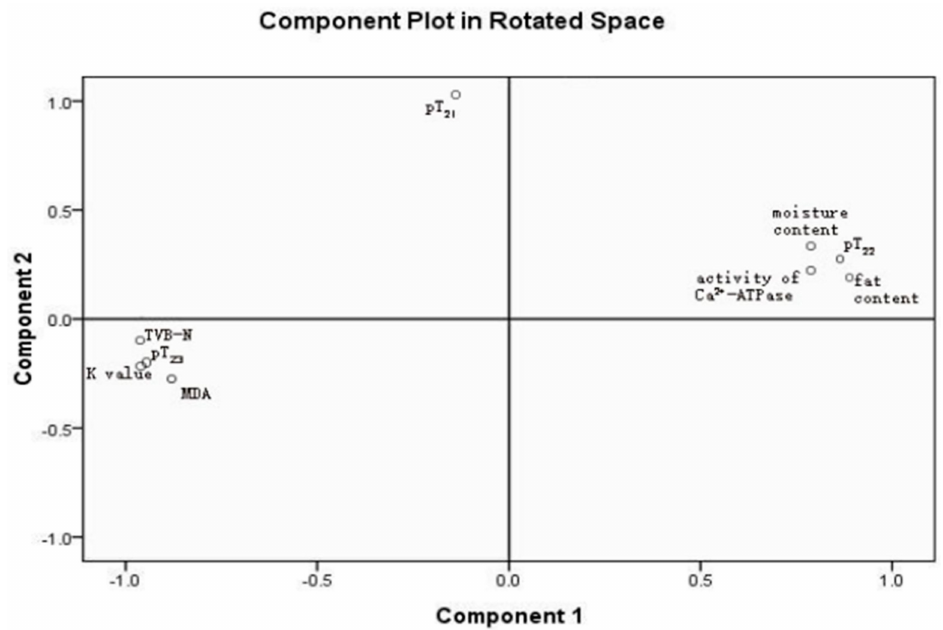
Figure 4. Principal component PC1 and PC2 score plot from the principal component analysis (PCA) of HTS fillets during refrigerated storage (CK1: distilled water + air packing; CK2: edible coating + air packing; C1: edible coating + MAP (60% CO 2 /40% N 2 ); C2: edible coating + MAP (65% CO 2 /35% N 2 ); C3: edible coating + MAP (70% CO 2 /30% N 2